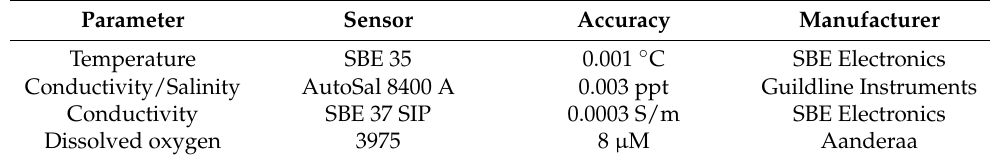
Table 2. The instrumentation of the